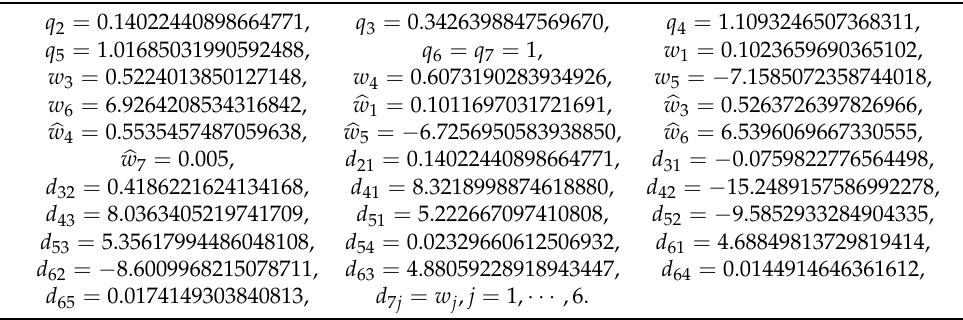
Table 5. Coefficients of the proposed here NEW5(4) pair, accurate for double precision computations.